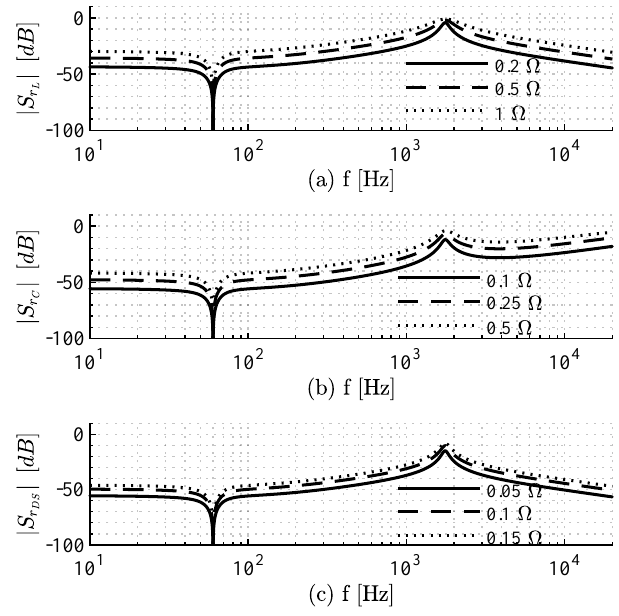
Figure 31. Sensitivity due to: ( a ) r L , ( b ) r C , and ( c ) r DS .